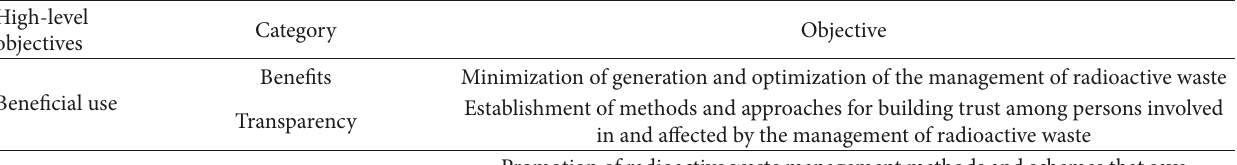
Table 6: Proposed hierarchical objective structure for comparison of nuclear waste management strategies taking into account IAEA categories